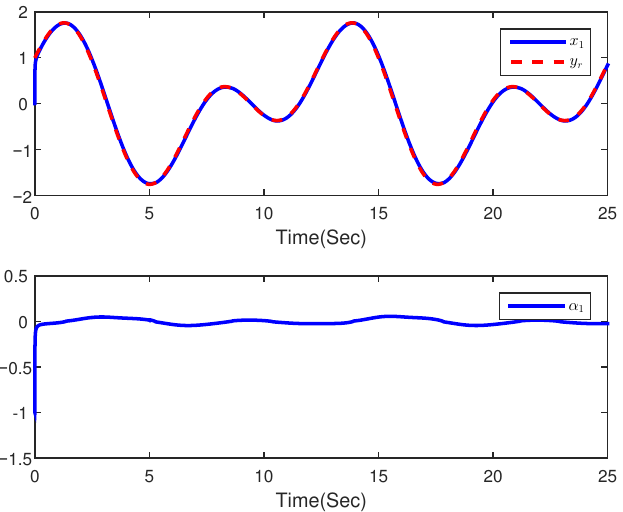
Figure 1. The output signal y and the desired signal y r , and the tracking error α 1 (Case